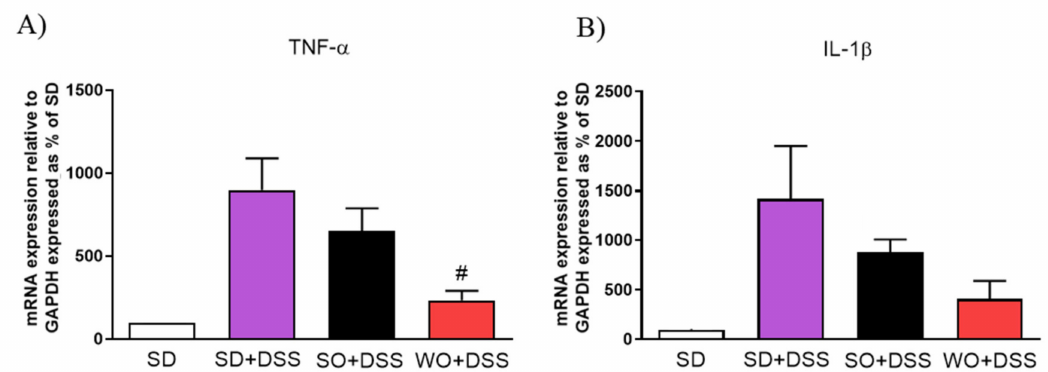
Figure 8. Changes in pro-inflammatory cytokines gene expression ( A , B ) in the colon of mice treated with DSS and fed with standard diet (SD), sunflower oil (SO), and walnut oil (WO). Values expressed as percent of control group. Data represent mean ± SEM, n = 8–12. # p < 0.05, as compared to DSS.